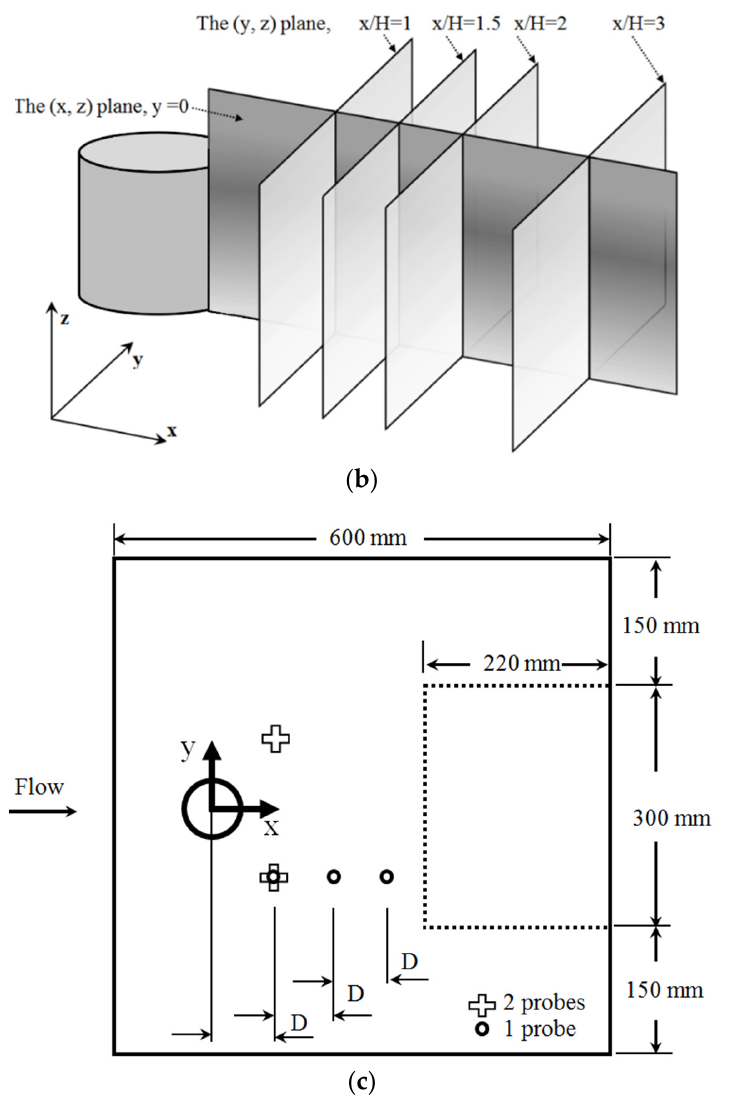
Figure 2. ( a ) Side view of DPIV experimental-setup and cylinder cross-sections. Laser position is for transverse (y – z) planes (upstream images) illumination. ( b ) Location of the some DPIV measurement planes. ( c ) Plan view of hot-film probe positions. The probe was positioned in y / D = ±1 and 1 ≤ x / D ≤ 3. Dotted line square shows the projection of the top access window on the base plate.